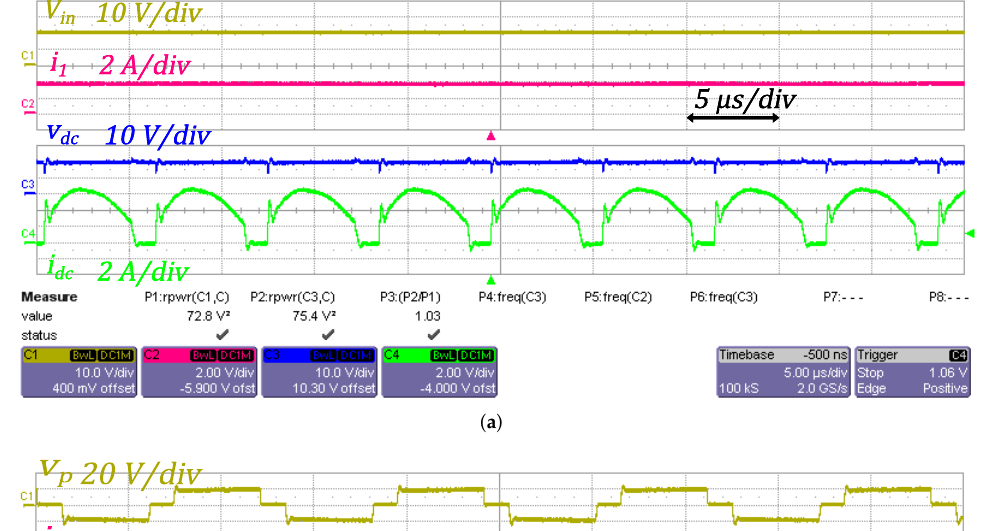
Figure 9. Experimental waveforms of the qZS-IPT system in boost mode with D = 0.2. ( a ) Input voltage V in and current i 1 , DC − link voltage v dc and current i dc . ( b ) primary side voltage v p and current i p , secondary side voltage v s and current i s . ( c ) Input voltage V in and current i 1 , output voltage V o and current I o .